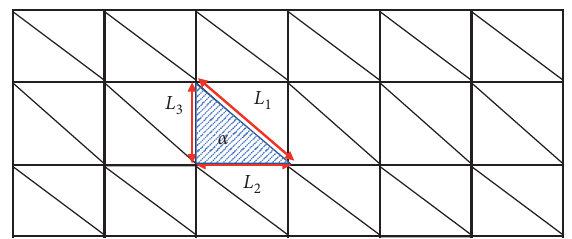
Figure 1: Measure of quality of the meshes.